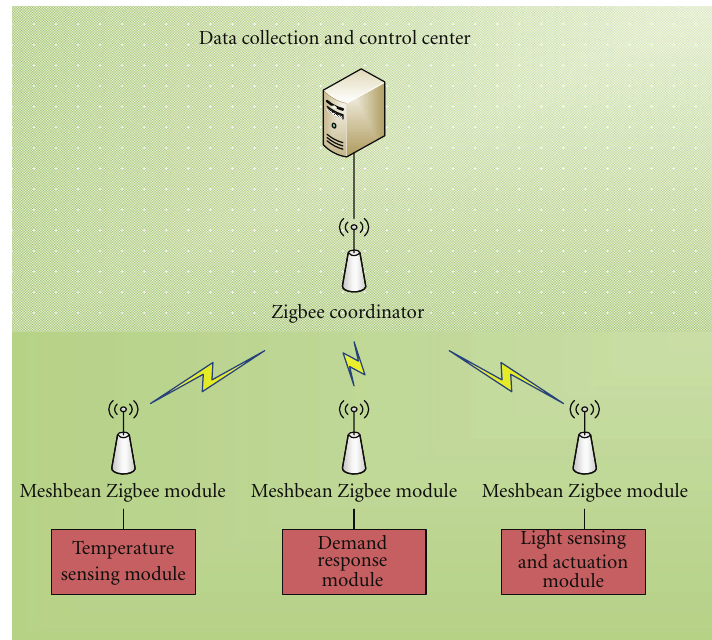
Figure 2: Zigbee HAN demonstration system architecture.